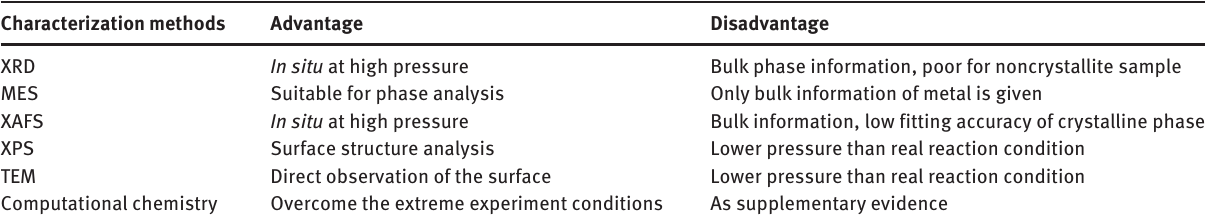
Table 4 Comparison of the in situ characterization used in iron catalyst.